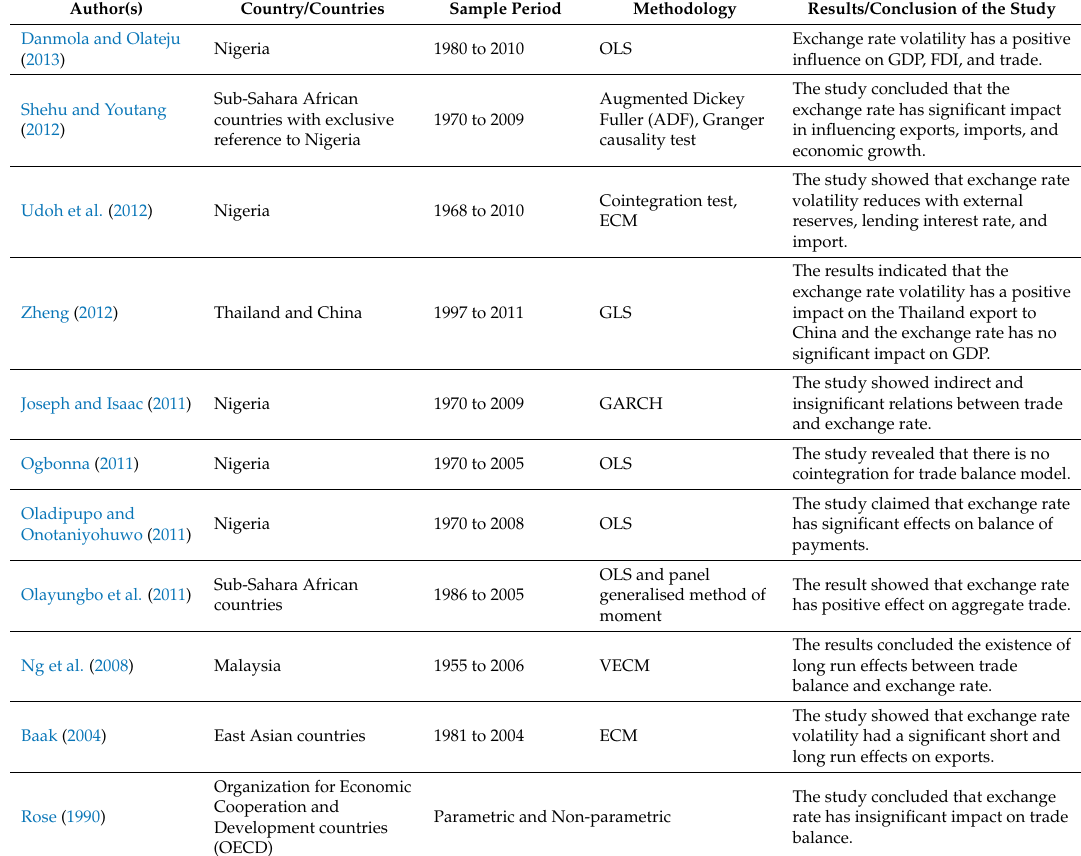
Table 1. Summary of empirical Evidence on trade balance and exchange rate.